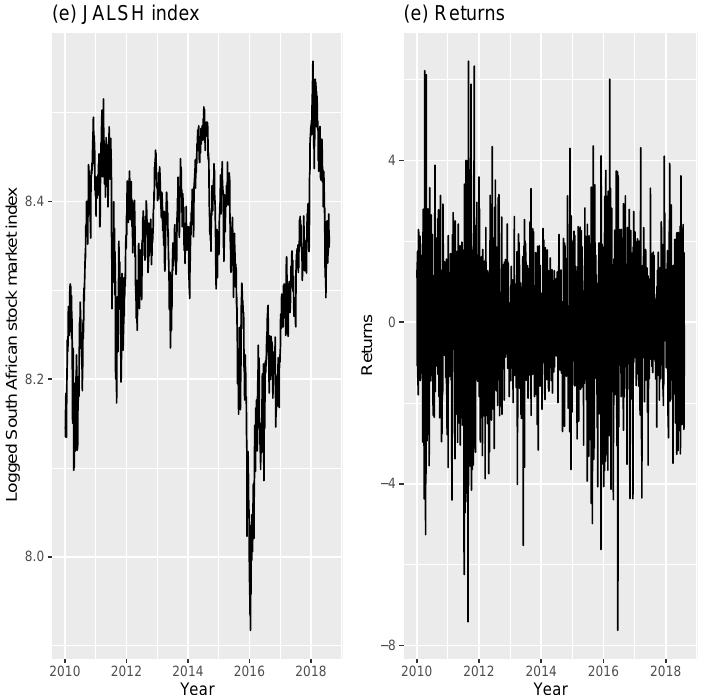
Figure 5. ( Left ) Plot of the South African stock market index; ( Right ) Plot of the